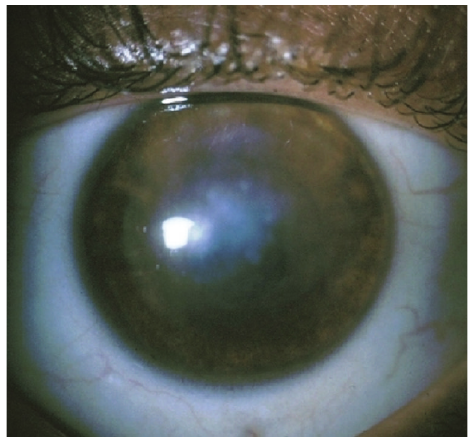
Figure 3: A slit lamp photograph of the left eye 4 months after initial presentation illustrates a central corneal scar without inflammation or